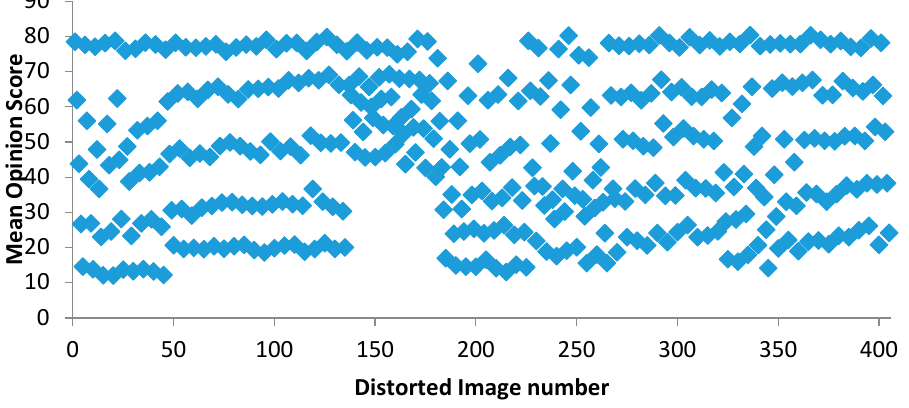
Figure 8. Average of the MOS for reference image.